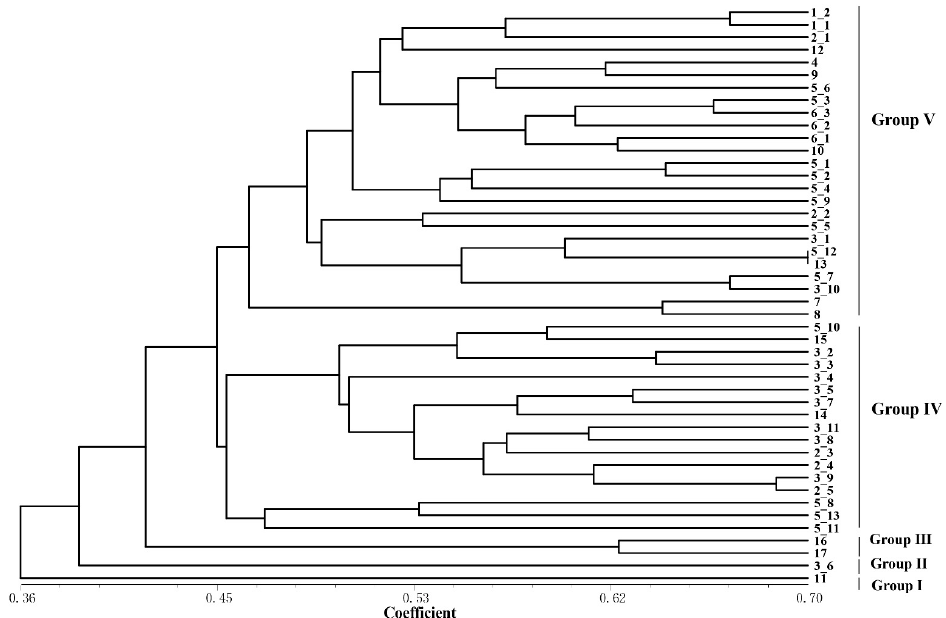
Figure 4. The genetic relationship dendrogram of IRAPs ampli fi cation from 46 rhododendron ac-